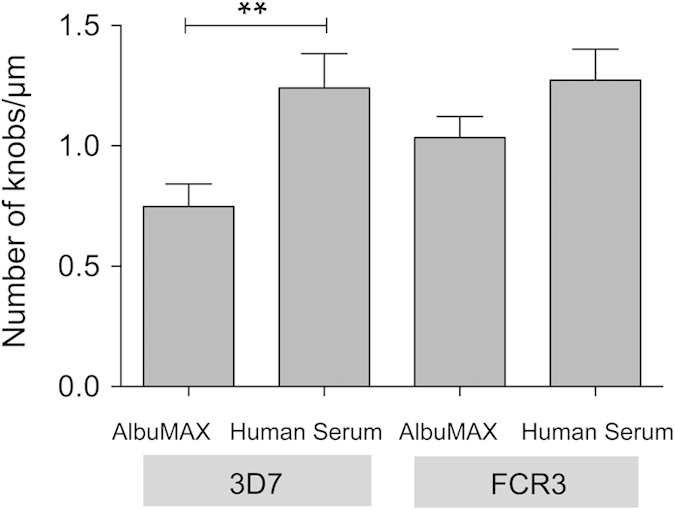
Determination of knob density on the surface of IEs infected by 3D7 and FCR3 cultivated in the presence of AlbuMAX or human serum.The number of knobs was calculated from electron microscopy images of isolates cultivated under different culture conditions after enrichment for knob carrying IEs. **p < 0.01.